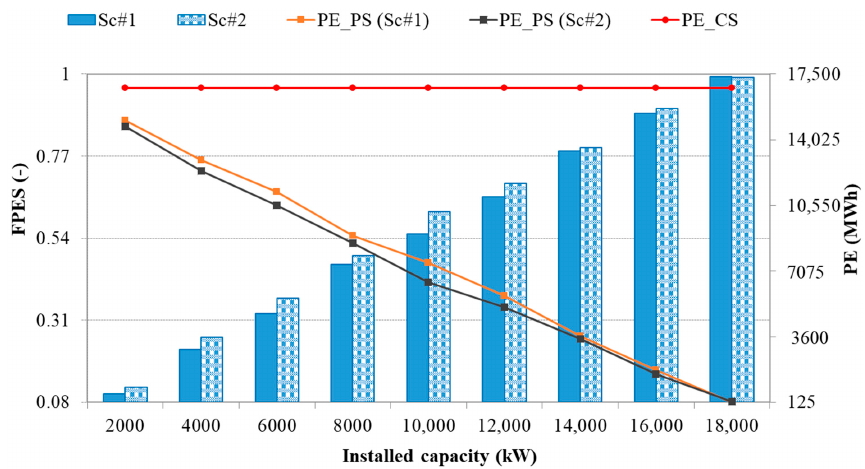
Figure 6. Fuel Primary Energy Saving index and primary energy demand of PS and CS in Sc#1 and Sc#2 as a function of PV systems power.